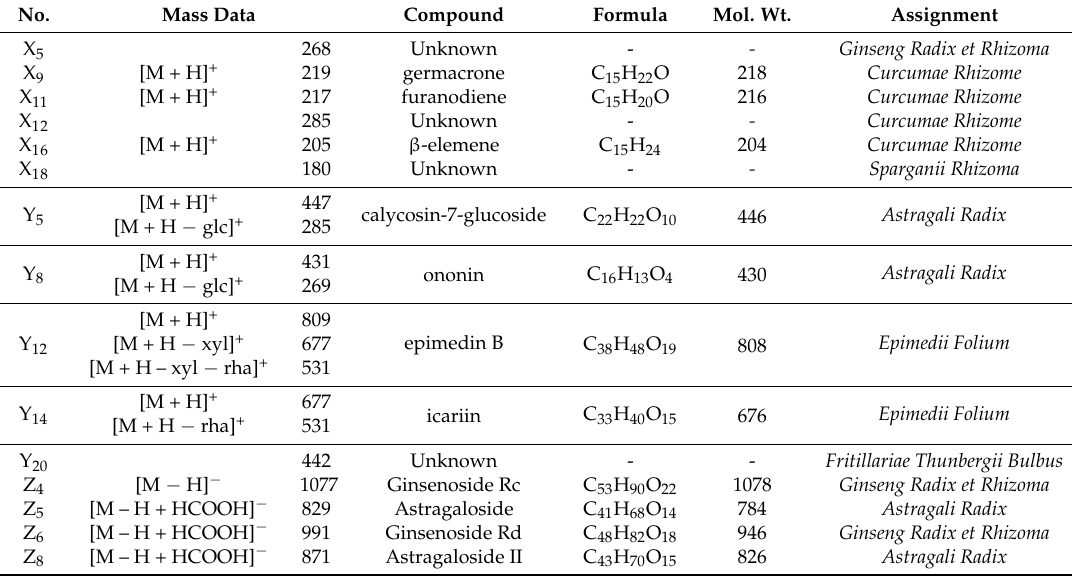
Table 1. Assignments of the correlated peaks.